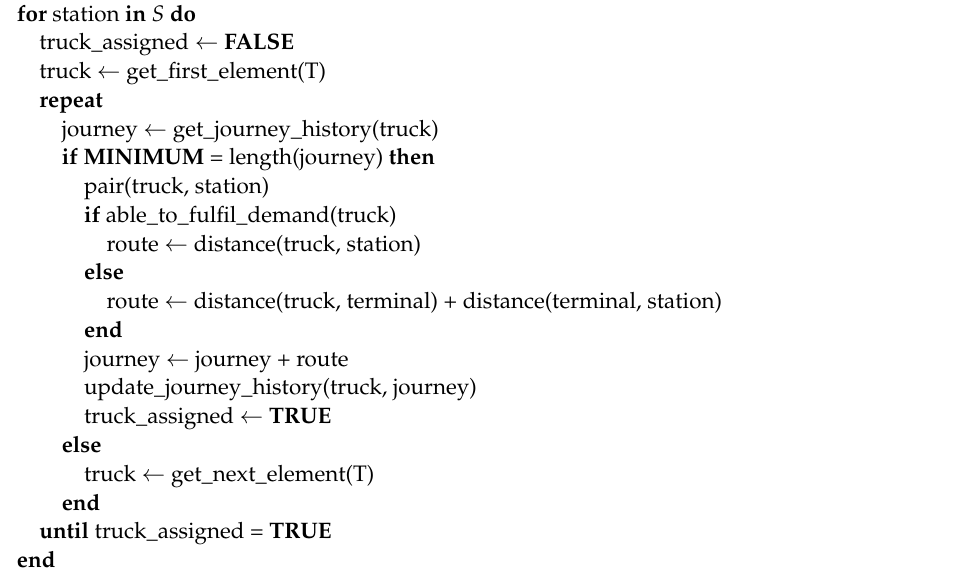
Algorithm 1. The decision algorithm for truck assignment.